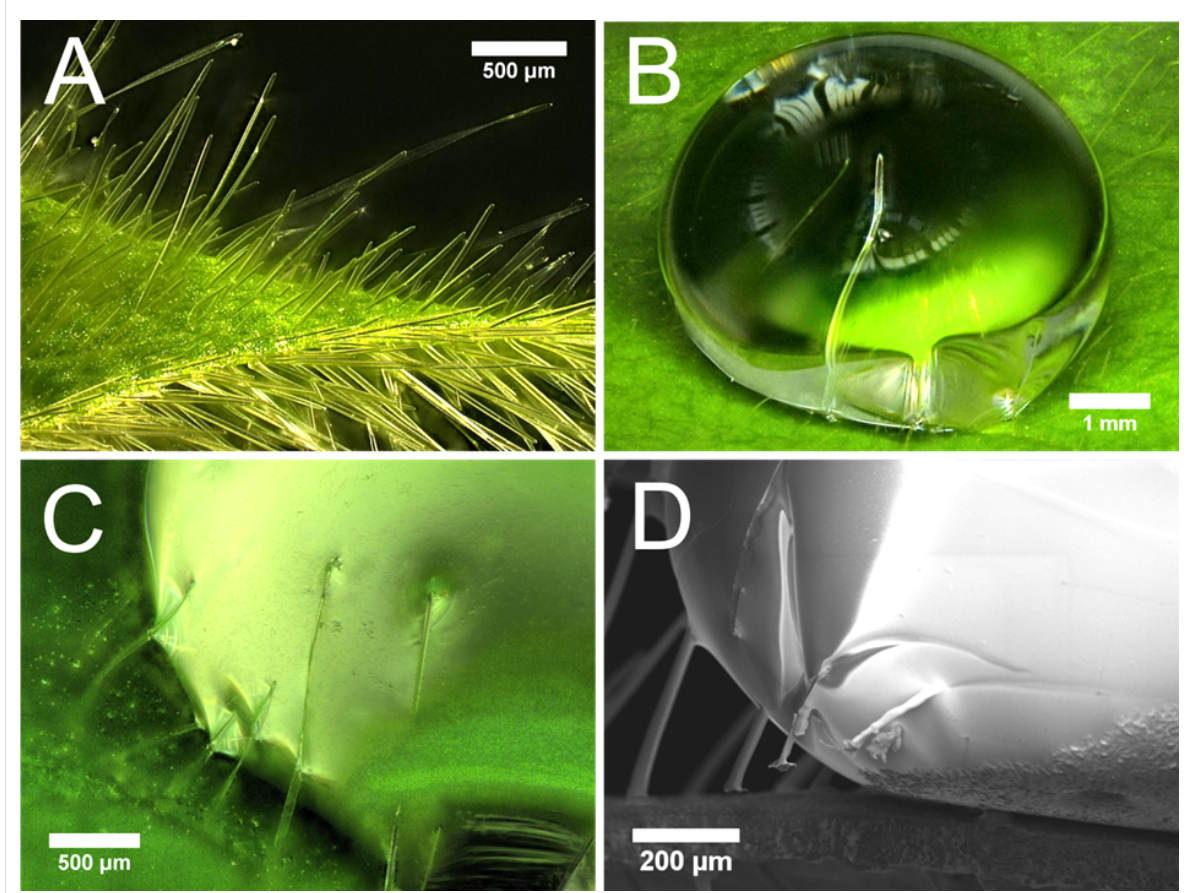
Figure 6: (A) 3D light microscopy images of fresh untreated leaf sample of Glycine max L. with long hairs on both leaf sides. The hydrophilic char- acter of the hairs is demonstrated by penetration of the hairs into the droplet (B) and the concave meniscus which occurs when hairs come into con- tact with droplets resting on the surface (C). In (D) a scanning electron micrograph of a frozen glycerol–water droplet in contact with the leaf surface of Glycine max L. is